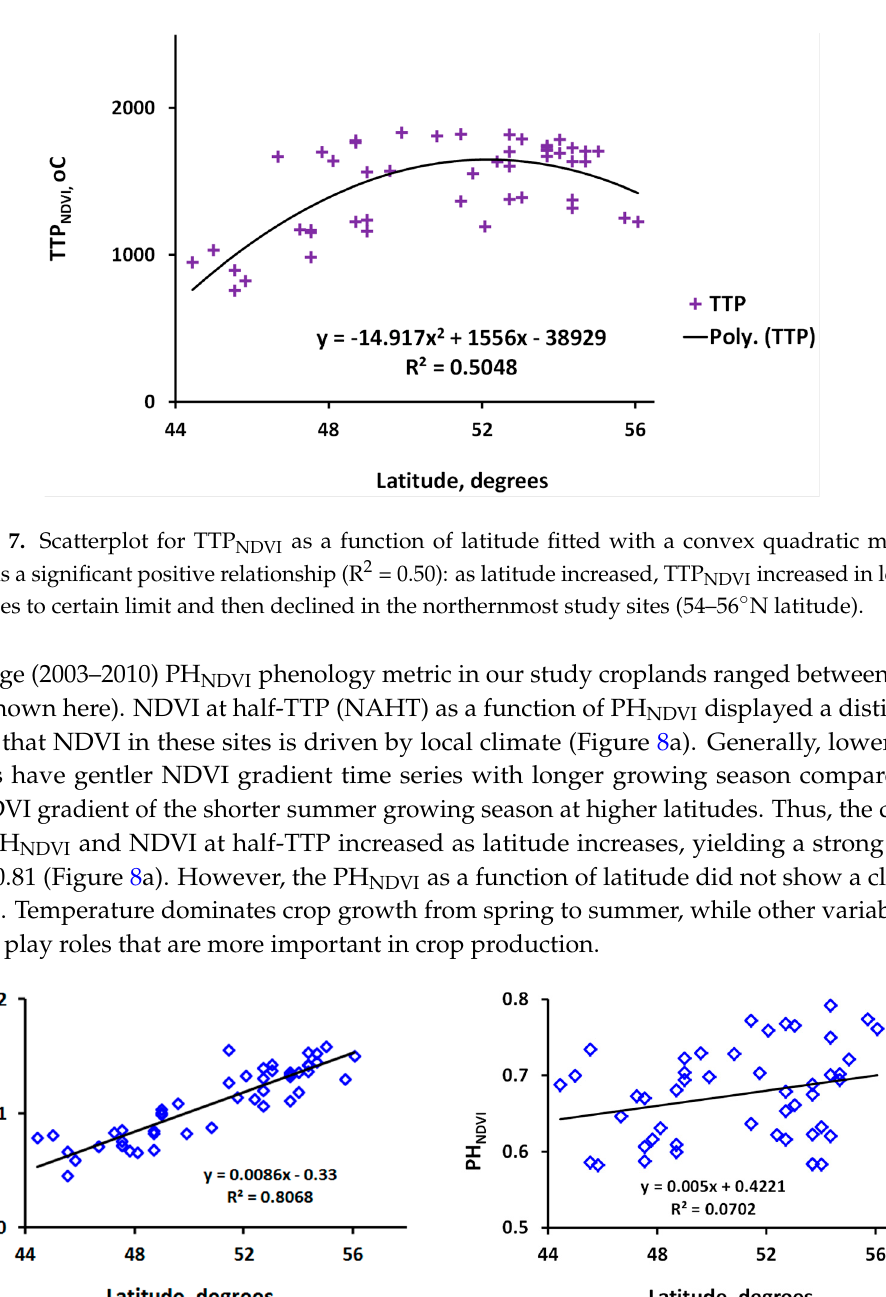
Figure 7. Scatterplot for TTP NDVI as a function of latitude fitted with a convex quadratic model. There is a significant positive relationship (R 2 = 0.50): as latitude increased, TTP NDVI increased in lower latitudes to certain limit and then declined in the northernmost study sites (54–56°N latitude).